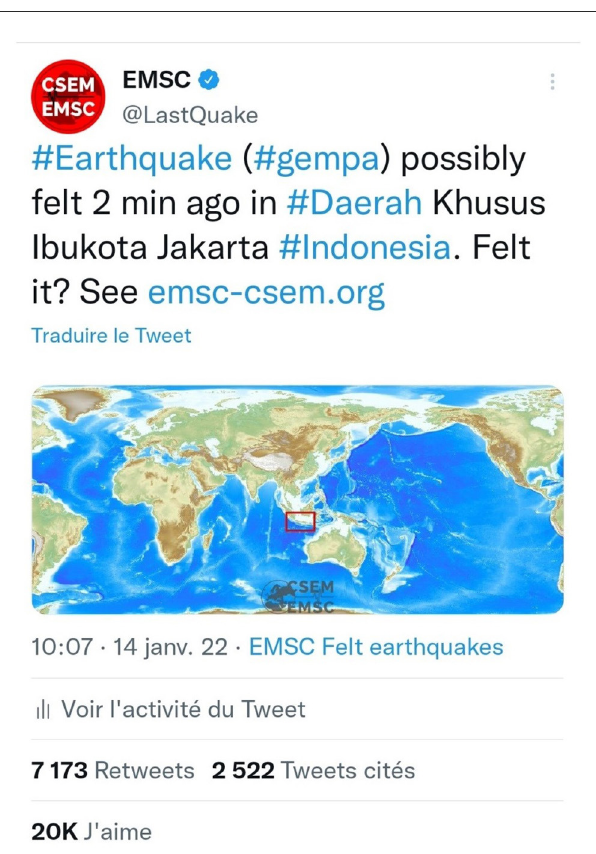
FIGURE2 An example of an automatic tweet reporting a crowdsourced detection, in this case based on the online reactions of eyewitnesses following a M6.6 earthquake in Sunda Strait in January 2022 that was widely felt in Jakarta. It includes a hashtag with the keyword earthquake in the local language (“gempa” in Indonesian), as well as the name of the region, the country, and a link to the EMSC website to encourage sharing of felt experiences. It was published 97s after the earthquake while the first seismic location was available 440s later. Two-thirds of the 438 felt reports collected were crowdsourced through the